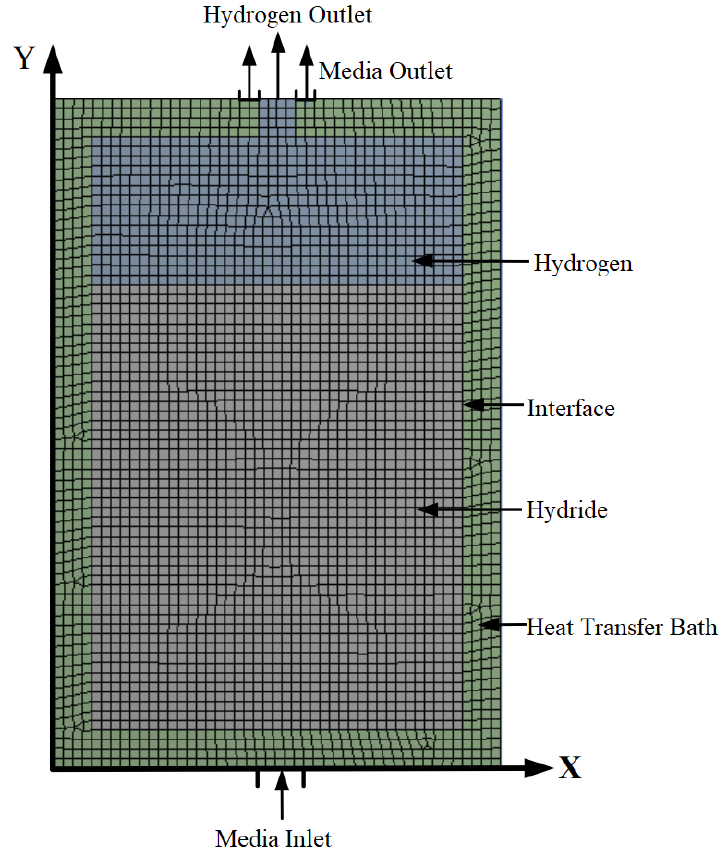
Figure 3. A hydrogen storage tank grid model with a heat transfer